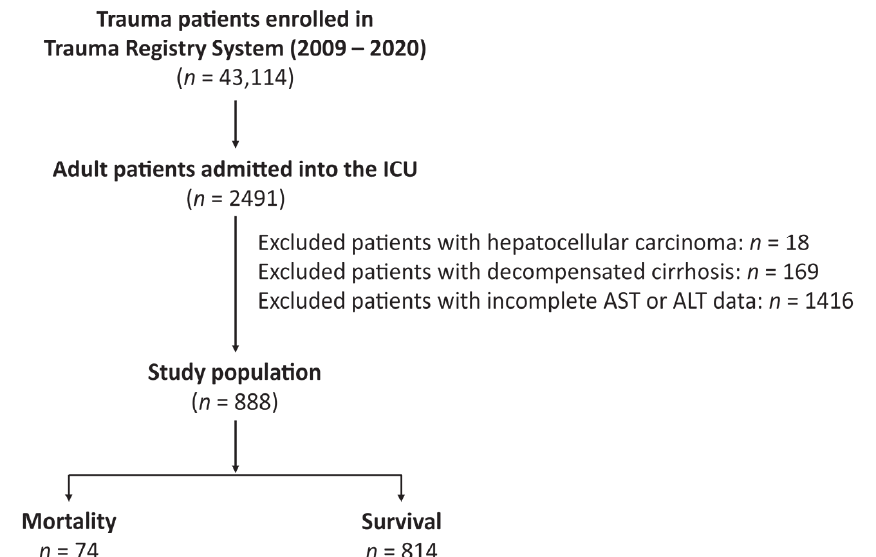
Figure 1. Flowchart demonstrating the inclusion of hospitalized adult trauma patients admitted into the intensive care unit. After the exclusion of patients who had hepatocellular carcinoma, pre-existed decompensated cirrhosis, and lacked AST or ALT data, the study population was grouped into the death ( n = 74) and survival groups ( n = 814).